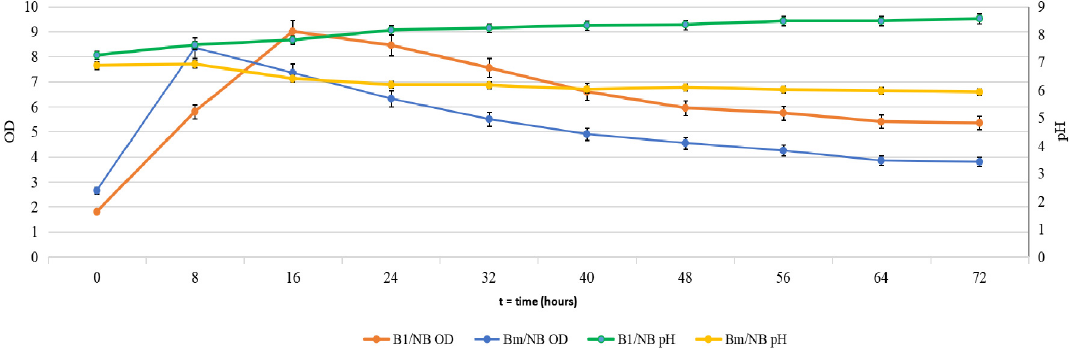
Figure 1. Growth of P. putida (B1) and B. mycoides (Bm) strains in NB medium.